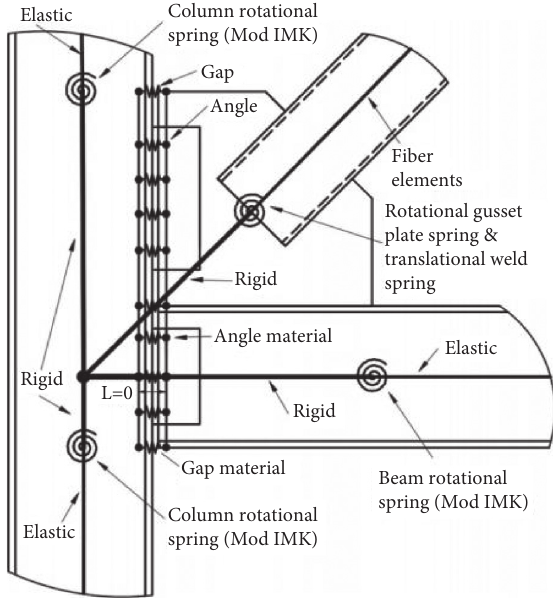
Figure 11: Numerical model schematic for connection zone of a braced frame beam-column [24].